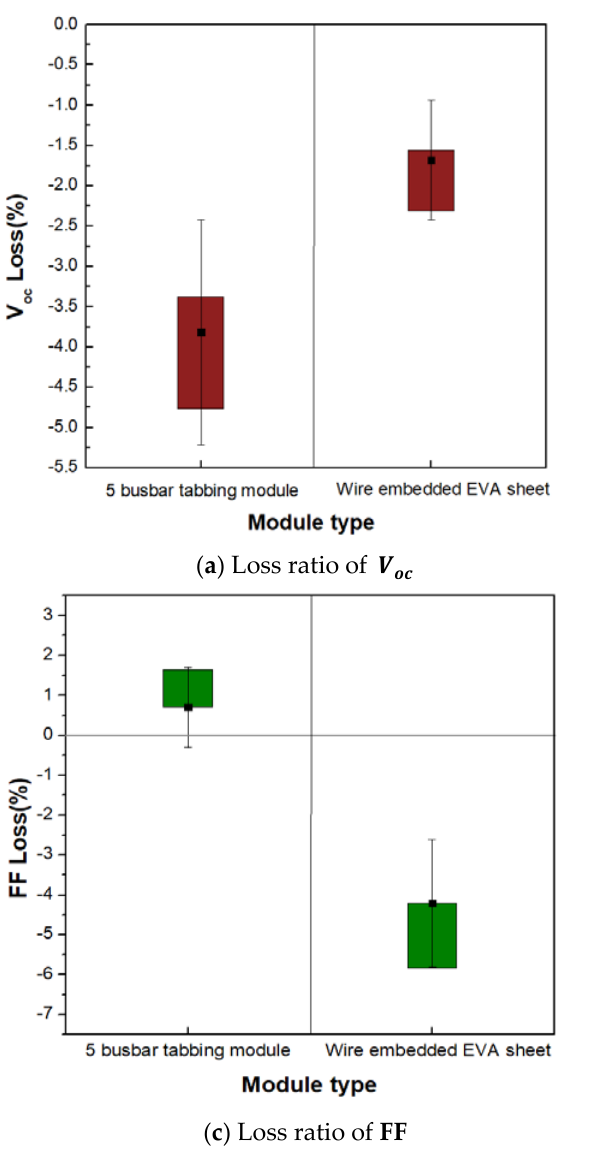
Figure 11. Characteristics for five-busbar tabbing module and wire-embedded EVA sheet module.